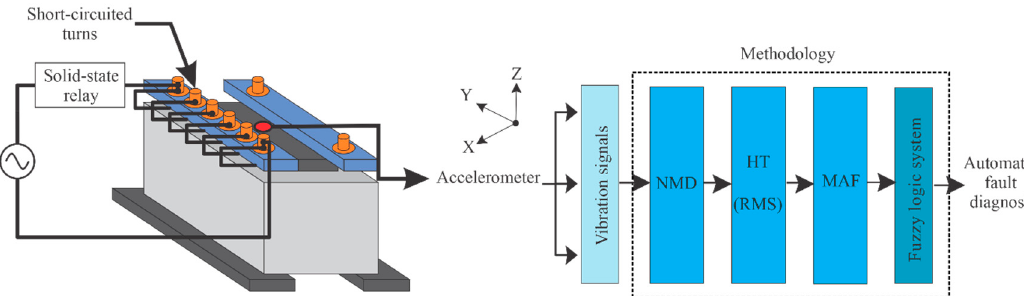
Figure 1. Flowchart for the proposed methodology.